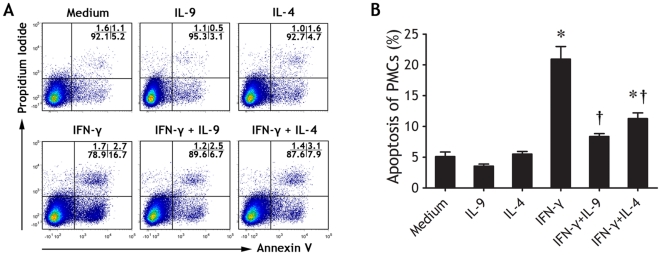
Effects of IL-9, IL-4 and IFN-γ on apoptosis of pleural mesothelial cells (PMCs).PMCs were seeded in Petri dishes in complete medium in the presence of one or more of IL-9, IL-4, and IFN-γ for 48 h. (A) The representative flow cytometric dot-plots are showing Annexin V/propidium iodide co-staining for identification of apoptotic PMCs. (B) Comparisons of apoptotic PMCs in each group (n = 5). The comparisons were determined by Kruskal-Wallis one-way analysis of variance on ranks, *p<0.05 compared with medium control, †p<0.05 compared with IFN-γ alone.